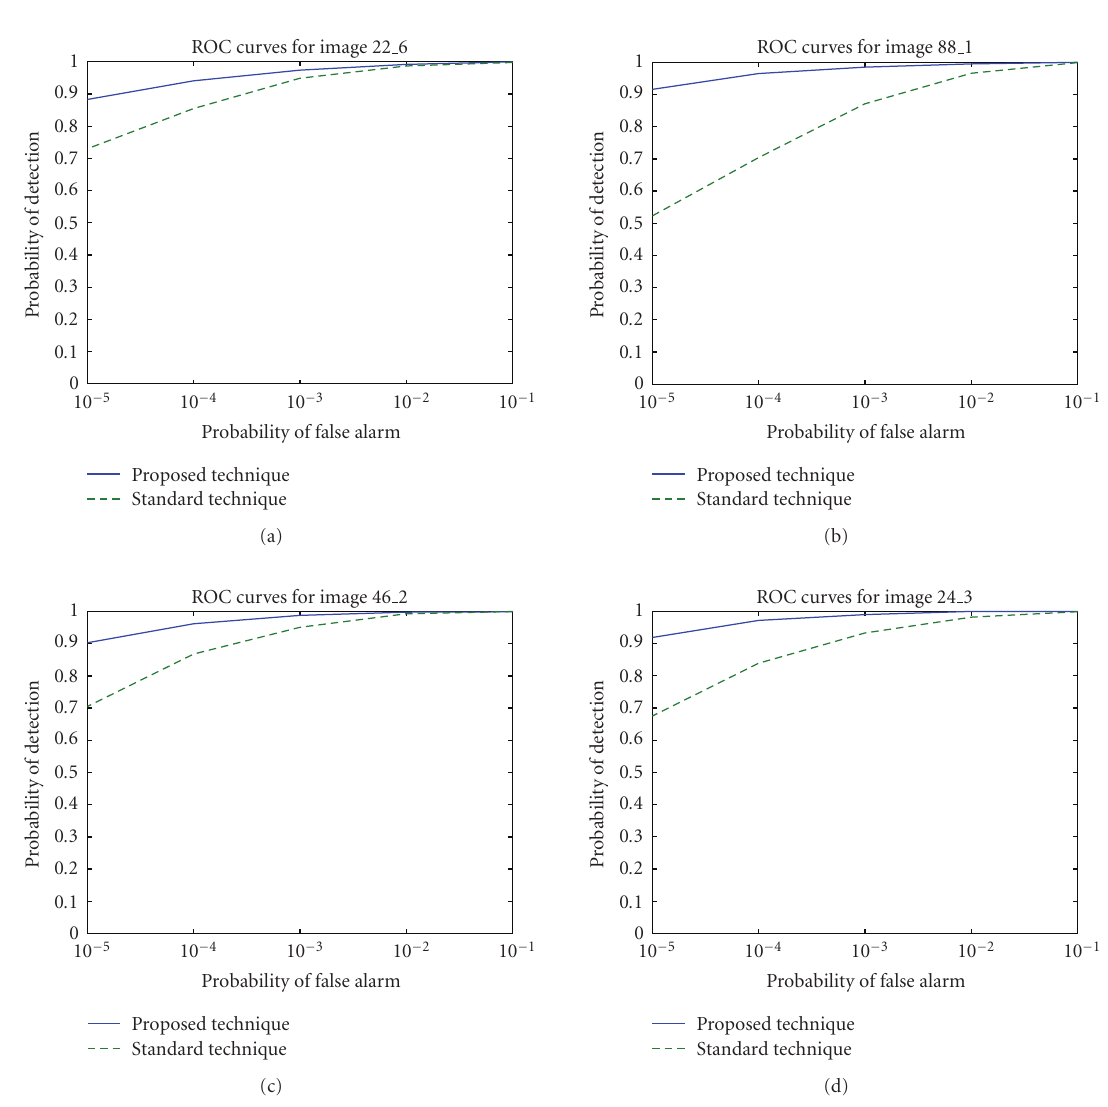
Figure 7: ROC curves of test images. Watermarking applied in the DFT domain. Strength λ = 0 . 10.